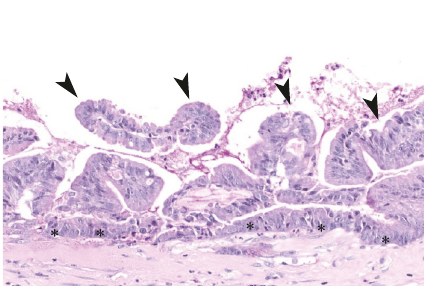
Figure 5: Microscopic changes: replacement of the normal appen- diceal mucosa with a villiform mucinous epithelial proliferation (arrow heads): crowded columnar cells with basal with elongated, hyperchromatic nuclei